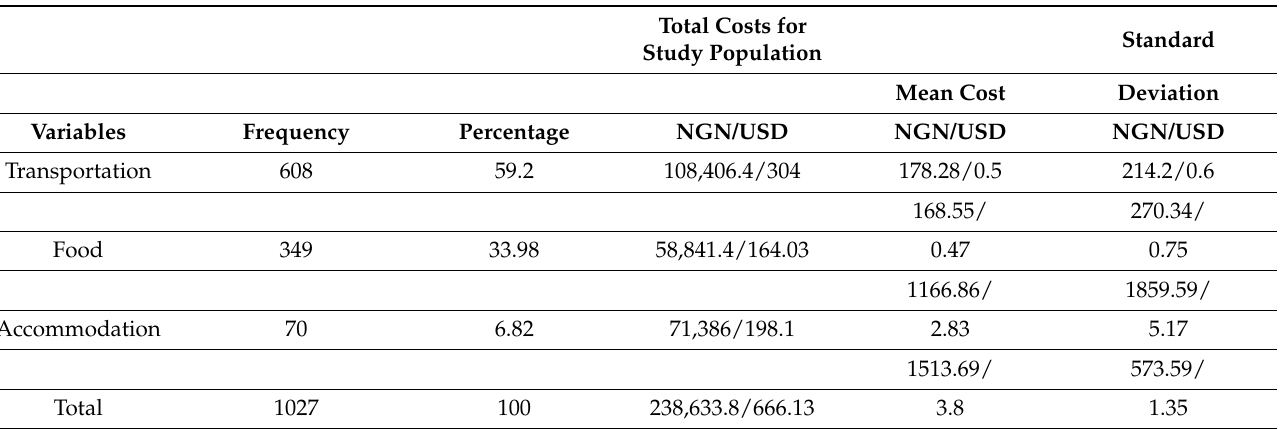
Table 3. Average direct non-medical costs per case of uncomplicated malaria in Plateau State (in Naira) (NGN) (Nigeria currency/USD) ( N = 956).